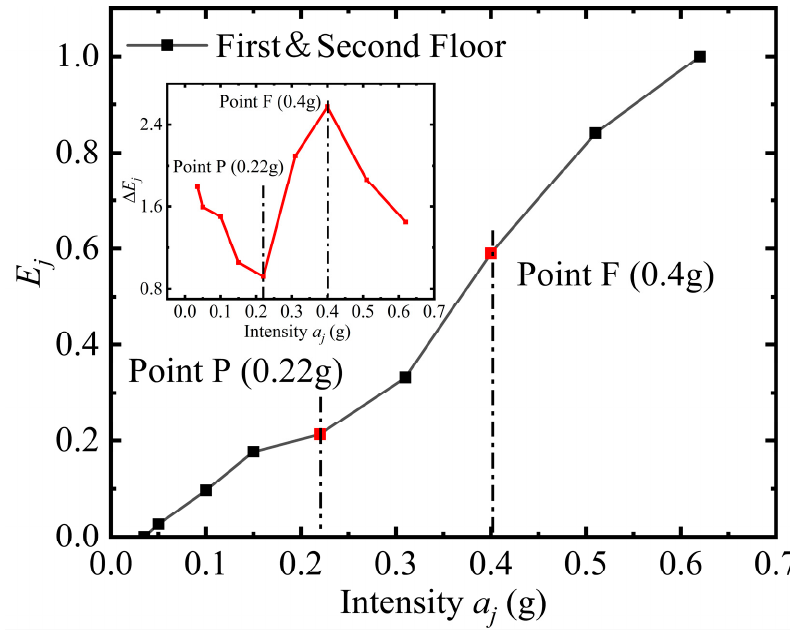
Figure 5. The stressing state mutation features of the bottom frame structure. The stressing state mode M j -a j curve corresponding to the E j -a j curve also shows distinctive sharp points and mutations near the failure characteristic points, as shown in Figure 6a,b. The horizontal coordinates of Figure 6a represent the seismic intensity, and the curves represent the different measurement points. The curves show turning and cusp features near the characteristic points P and Q. The horizontal coordinates of Figure 6b represent different measurement points in space, and the curves represent different seismic intensities. The curves show the mode’s leap near the characteristic points.